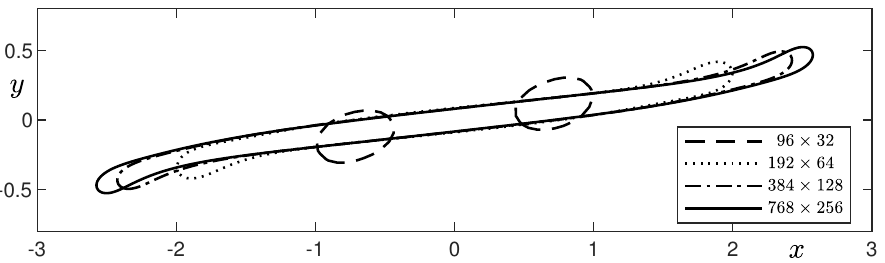
Figure 7. Convergence result at time t = 7 for the mesh refinement of the deformed droplet in simple shear flow. Figure 8a,b show the temporal evolution of a thin rectangular shape without